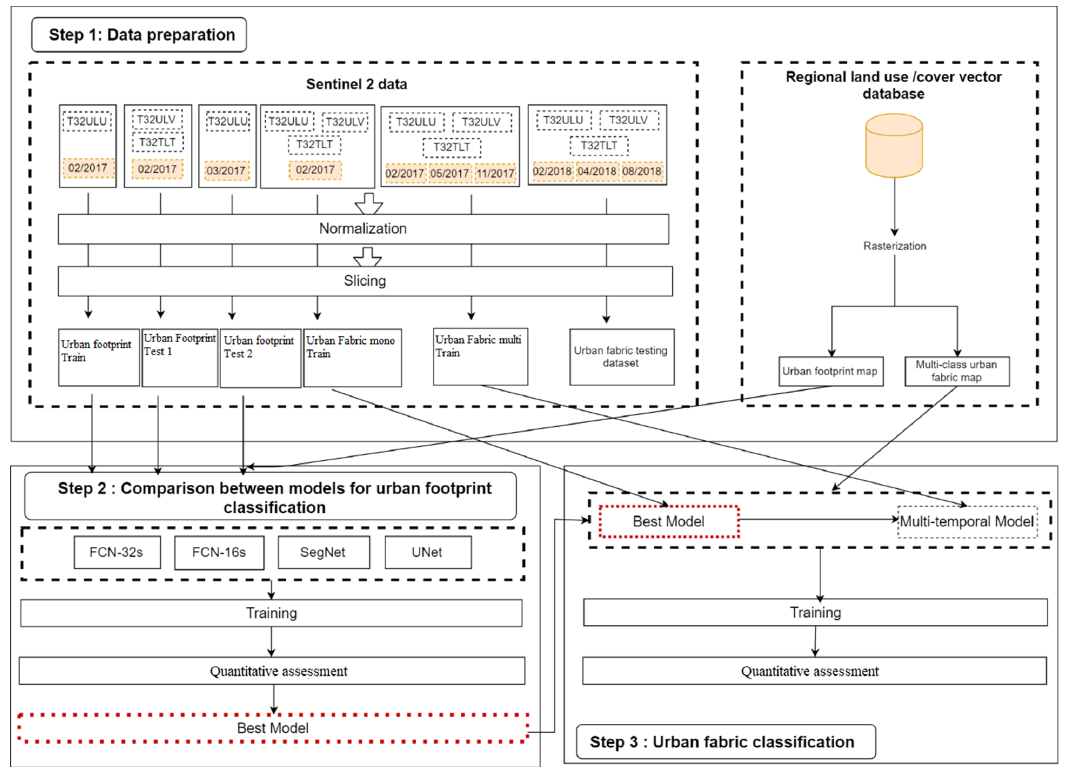
Figure 3. General workflow applied on Sentinel 2 imagery to assess the potential contribution of the temporal dimension to map UF.